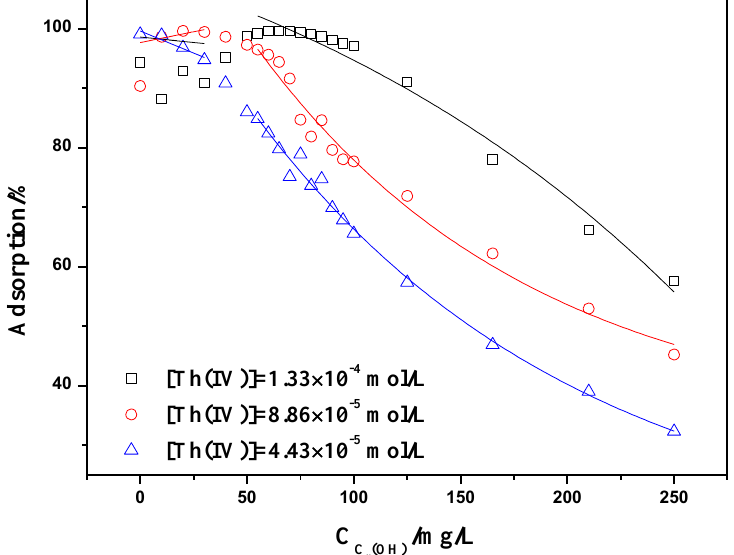
Figure 12. Effect of oMWCNT dosage on Th(IV) adsorption on oMWCNTs as a function of C (OH) initial concentrations, pH = 3.20 ± 0.05, I = 0.01 mol/L NaNO 60 n T = 25 ± 1 °C, C[Th 4+ ] initial = 8.86 × 10 −5